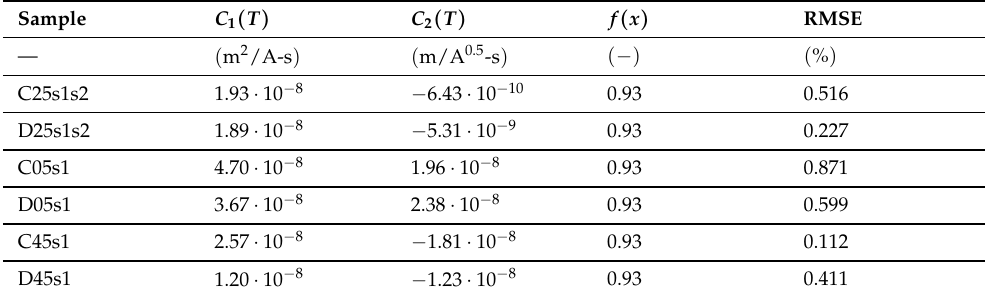
Table 8. Fitted parameters C 1 ( T ) , C 2 ( T ) and f ( x ) to experimental data at temperatures 25, 5 and 45 ◦ C from the optimizer.